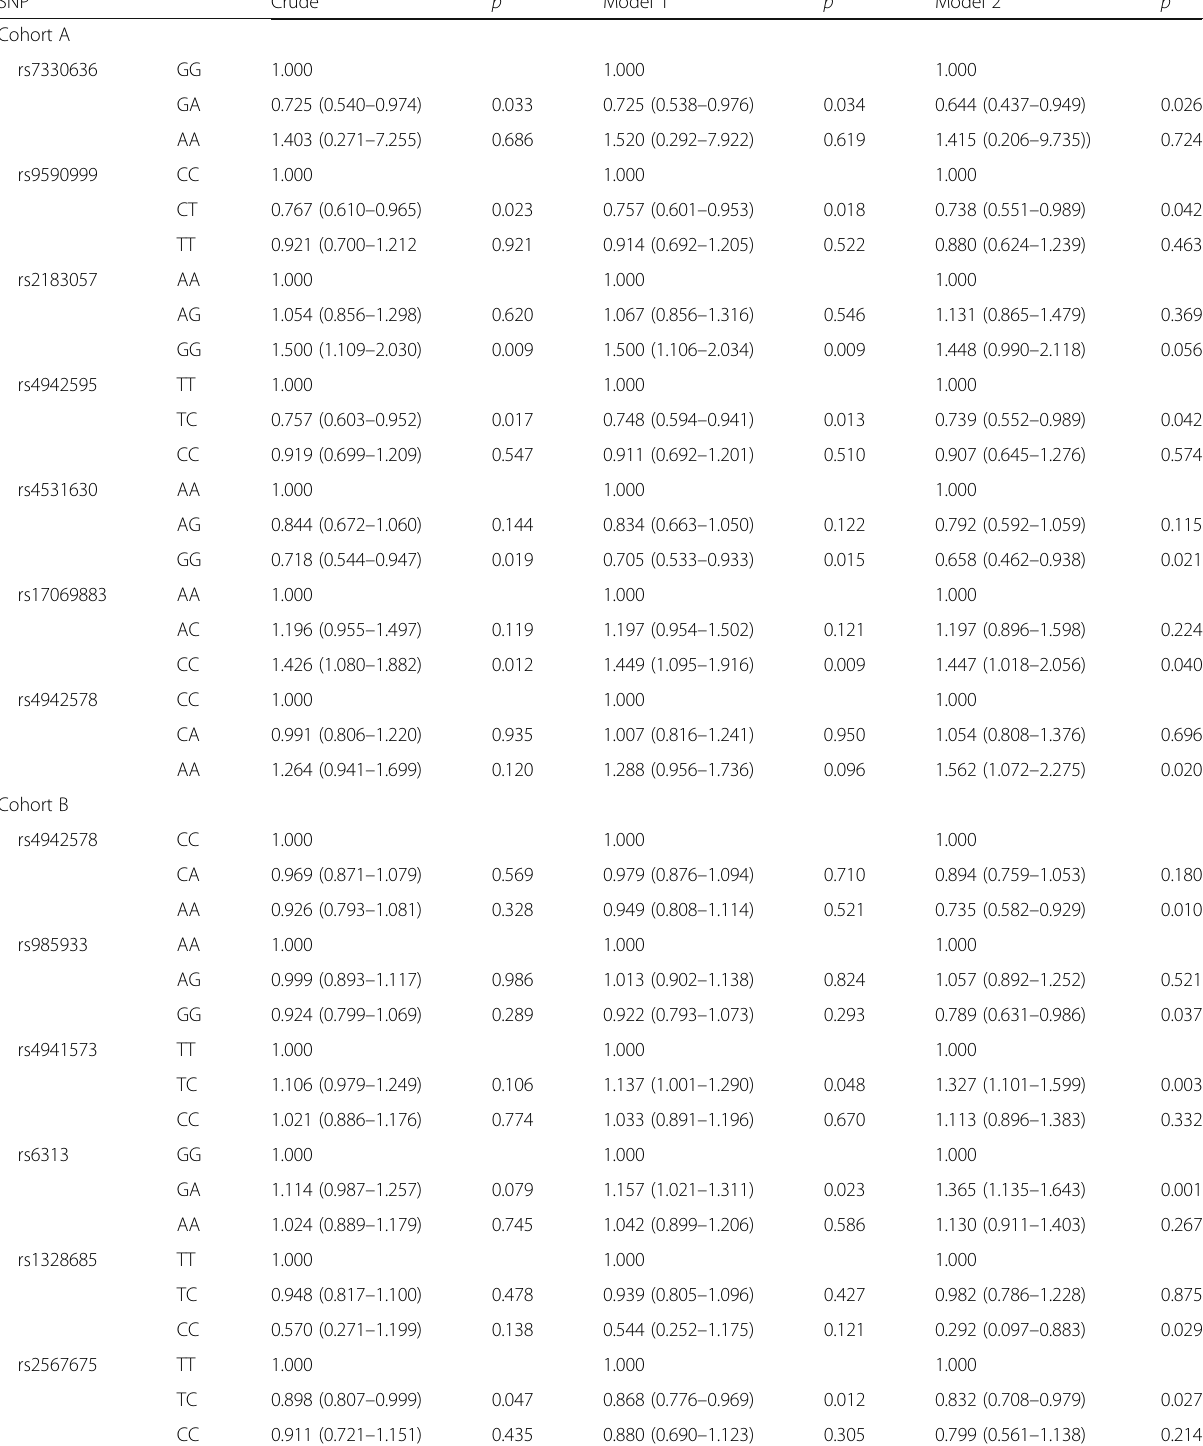
Table 3 Association of genetic polymorphisms of HTR2A gene and risk of hypertension